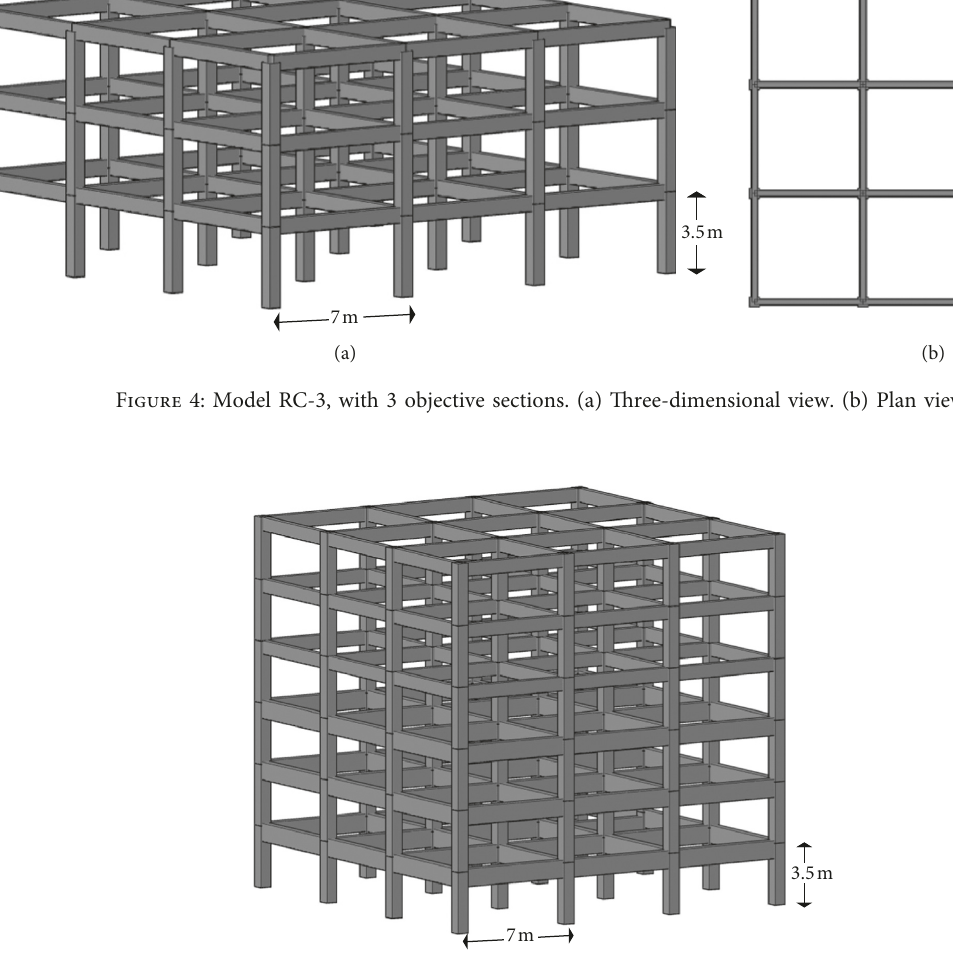
Figure 5: Model RC-6, with 5 objective